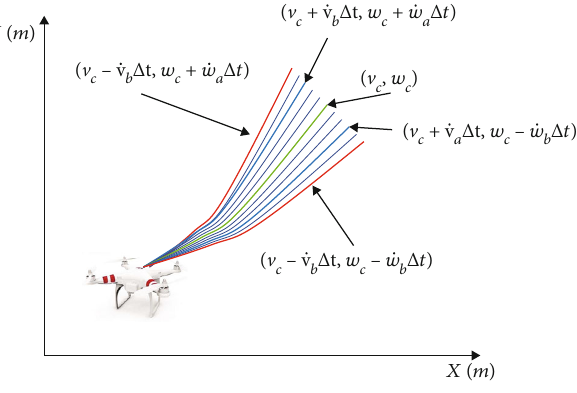
Figure 7: UAV trajectory